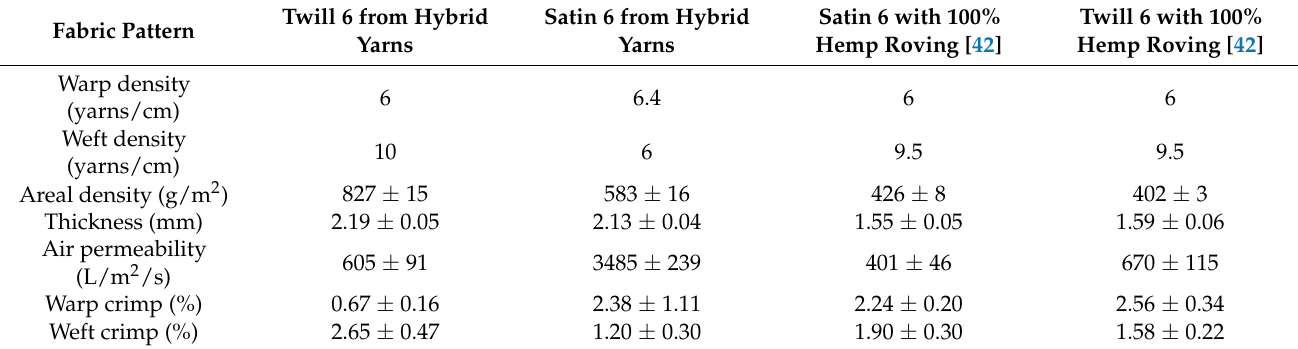
Table 3. The textiles properties of the woven fabrics of this study and Corbin et al. [42]